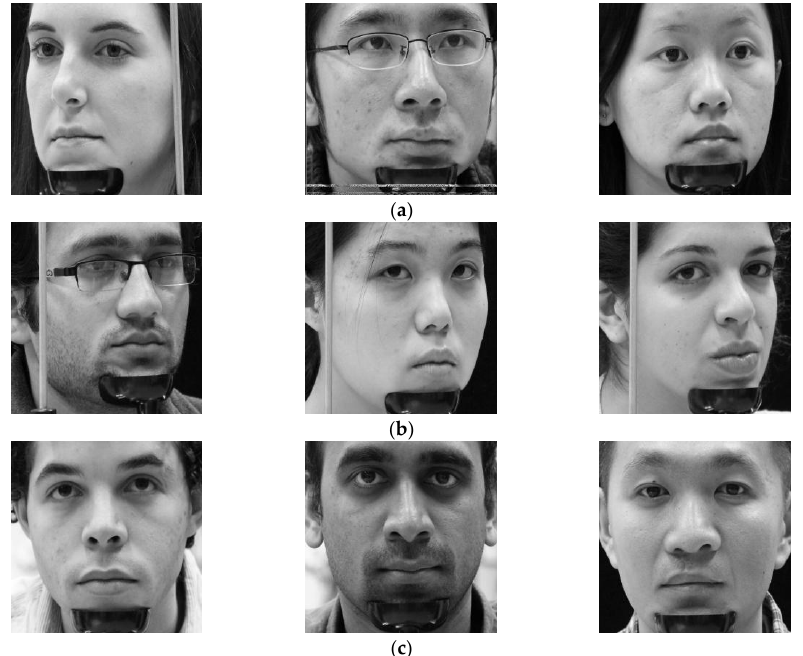
Figure 16. Correctly detected gaze zones with our system on CAVE-DB. Left, middle, and right figures respectively show the cases that the user looks at gaze zones of ( a ) 1, 4, and 7; ( b ) 2, 5, and 8; ( c ) 3, 6, and 9, respectively, of Figure 15.